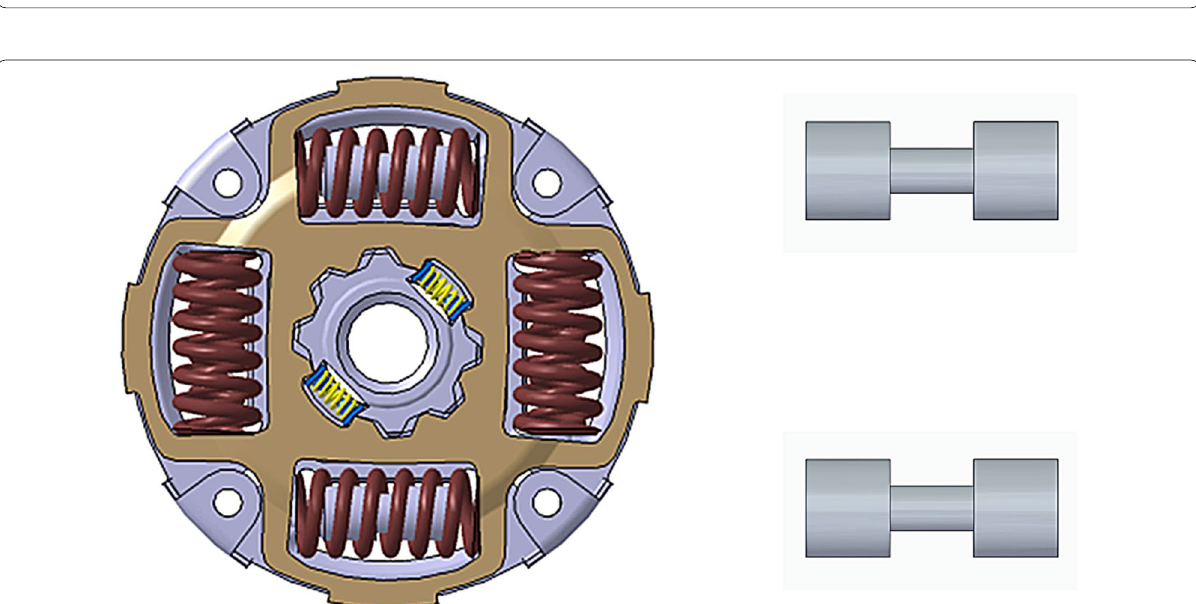
Figure 12 Diagram of rubber spring set (installed inside large